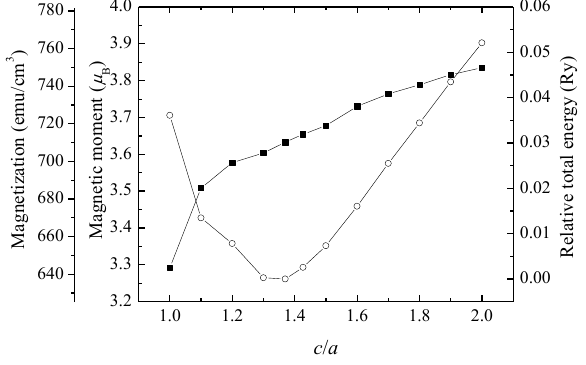
Figure 5. The c / a dependence of magnetic moment and relative total energy for